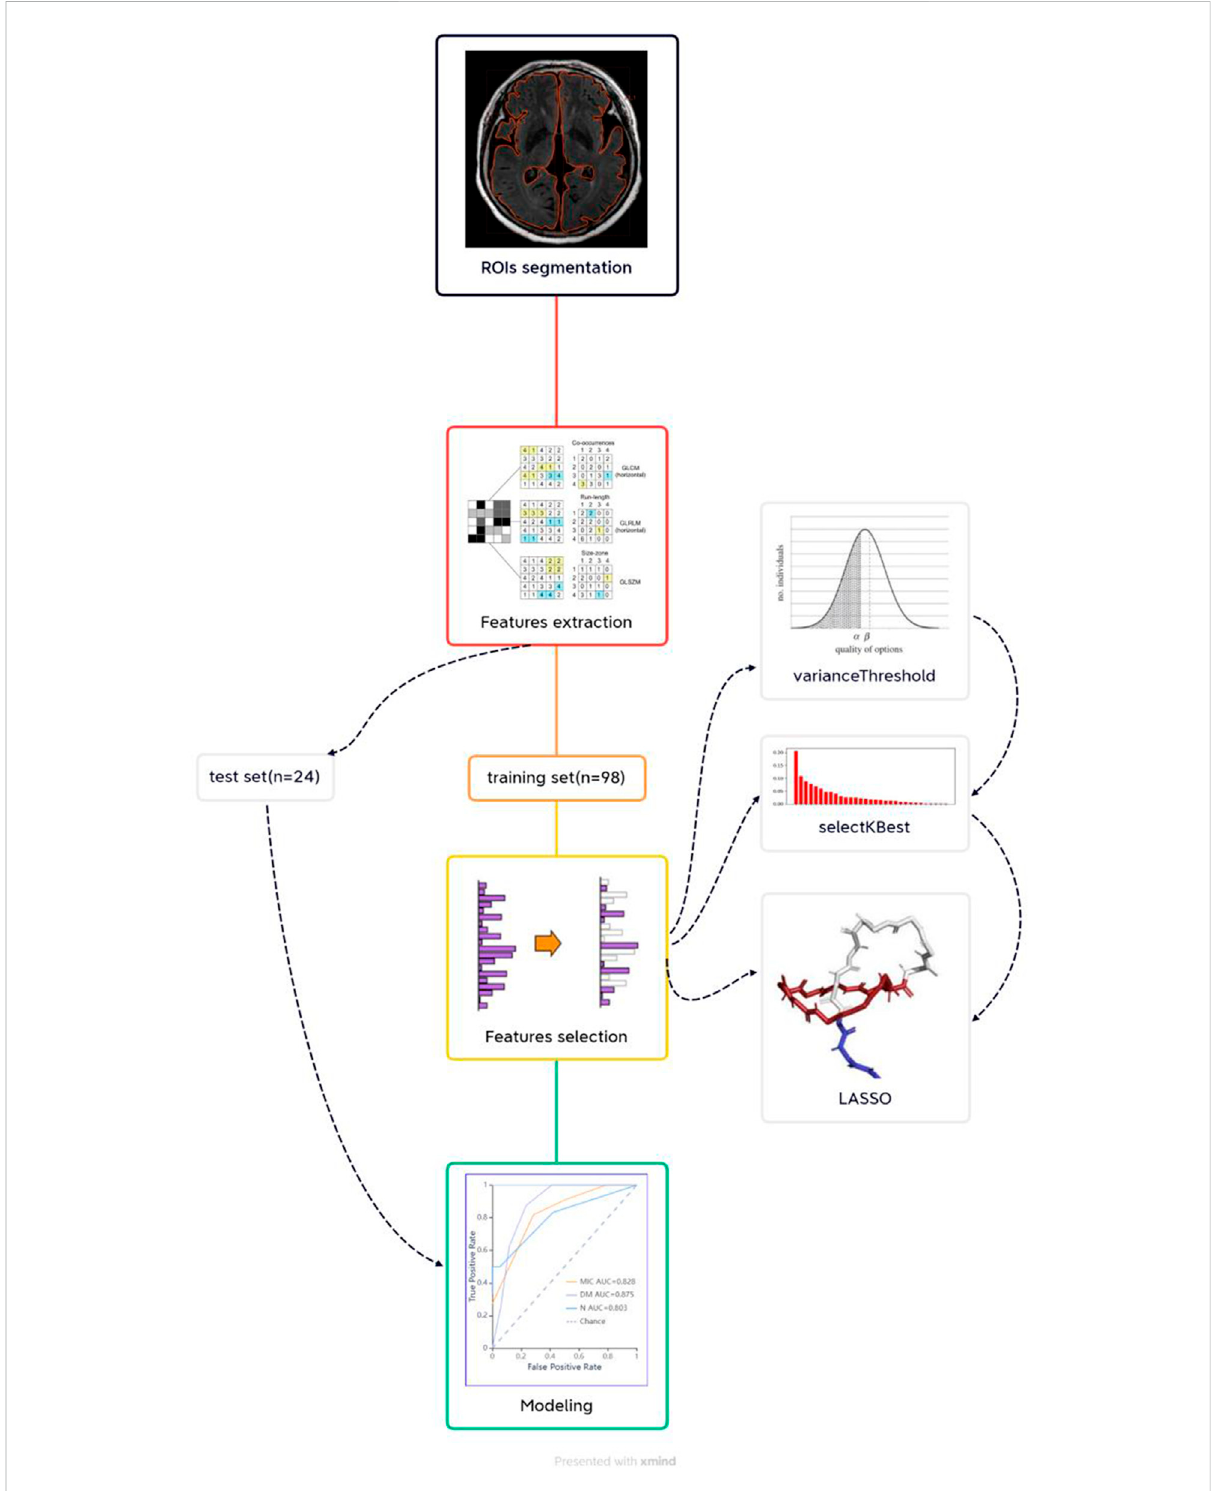
FIGURE 1 Radiomics work fl